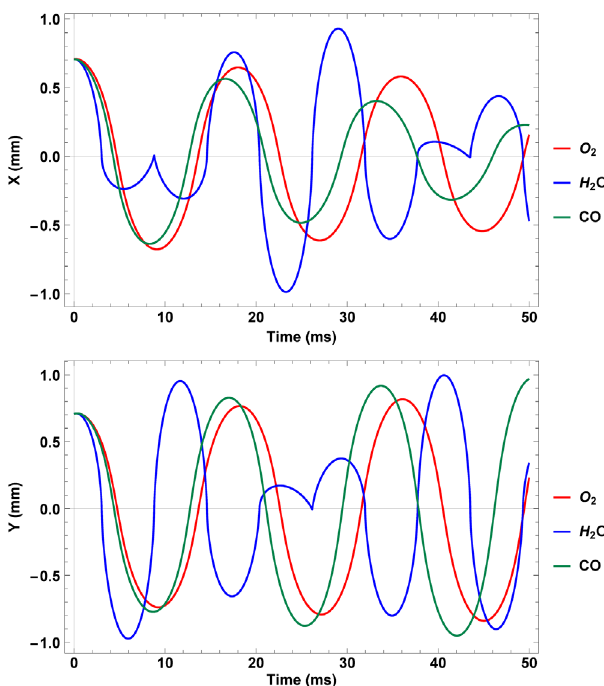
FIG. 11. Motion of neutral flakes of molecules initially at 1 mm from the thin-wire beam with a thermal velocity corresponding to a temperature of about 15 K, and subjected to the electromagnetic field of the beam, in the horizontal (top) and the vertical direction (bottom). Different colors correspond to different types of constituent molecules as indicated.